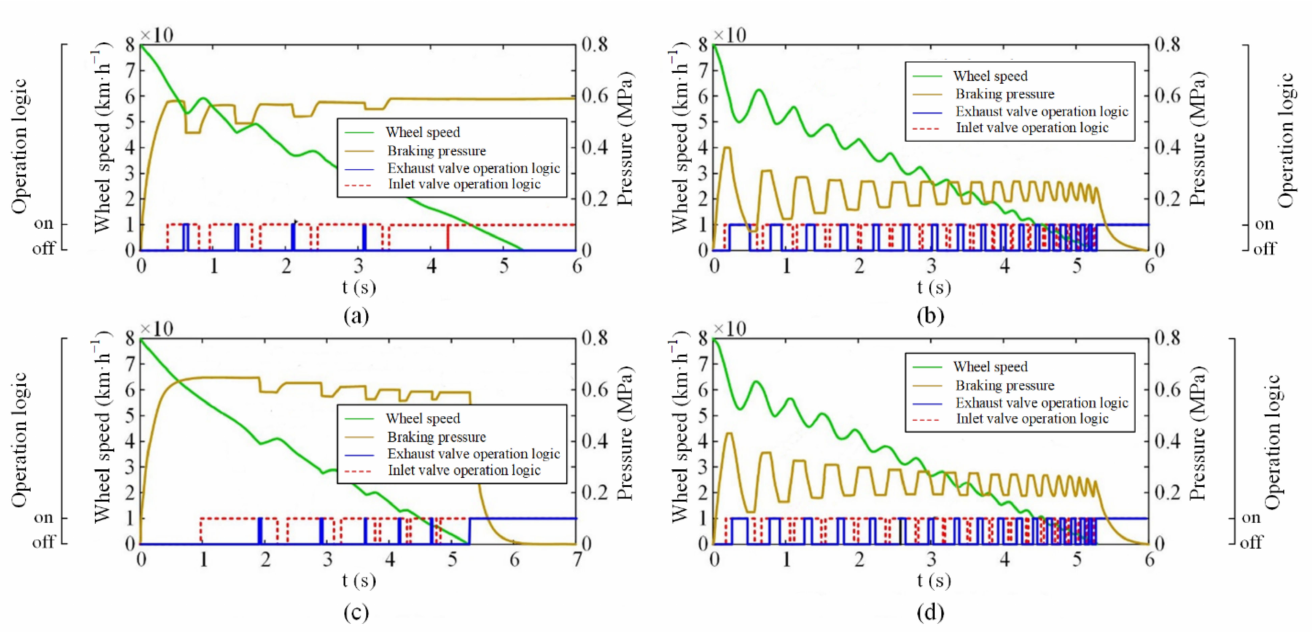
Figure 7. Simulation results of wheel speed simulation model on bisectional road: ( a ) first axle left wheel; ( b ) first axle right wheel; ( c ) second axle left wheel; ( d ) second axle right